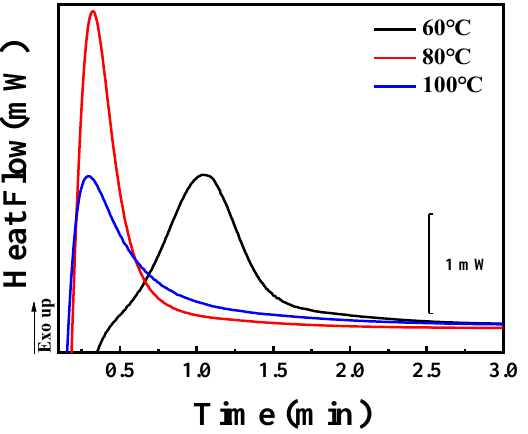
Figure 9. The kinetics of cold crystallization of the PLLA/TAIC (60/40) blend at the indicated temperatures.